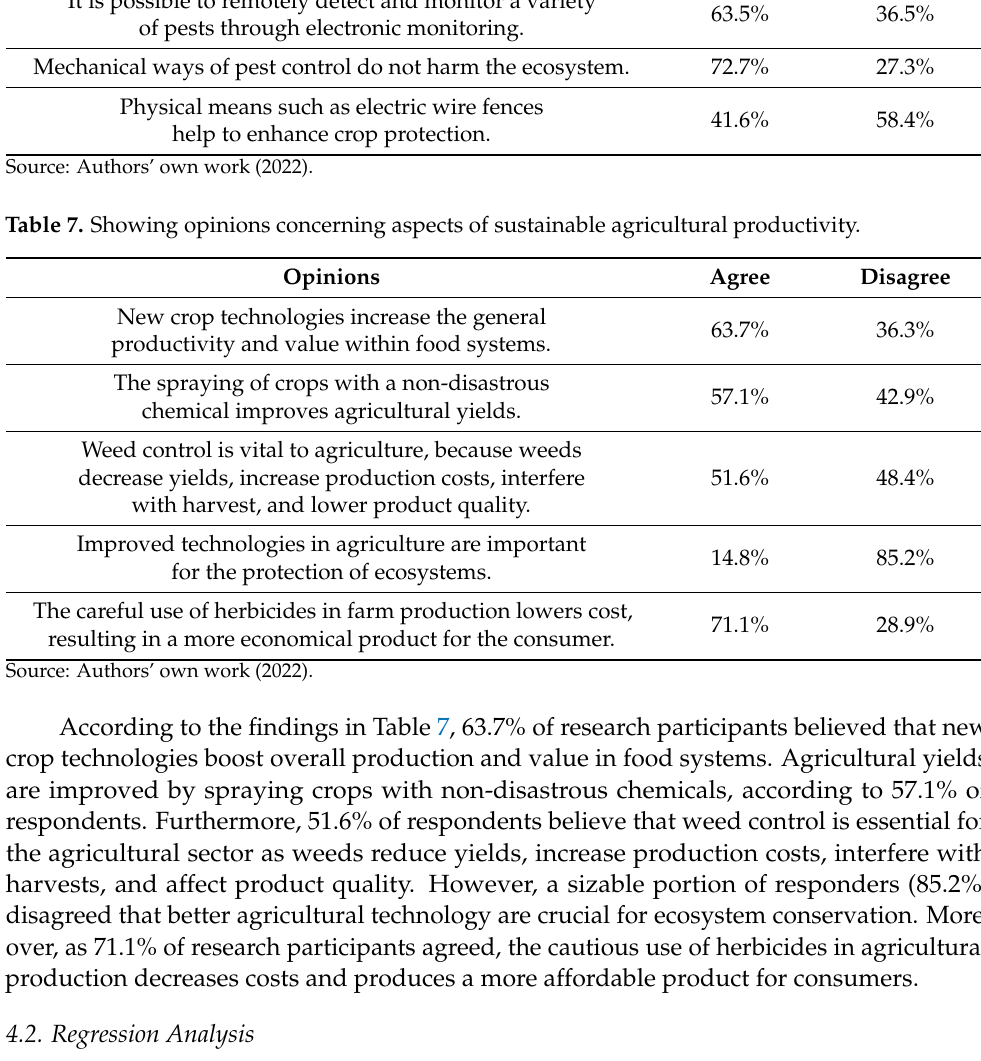
Table 6. Showing the opinions on mechanical techniques with regard to crop protection. Opinions Agree Disagree